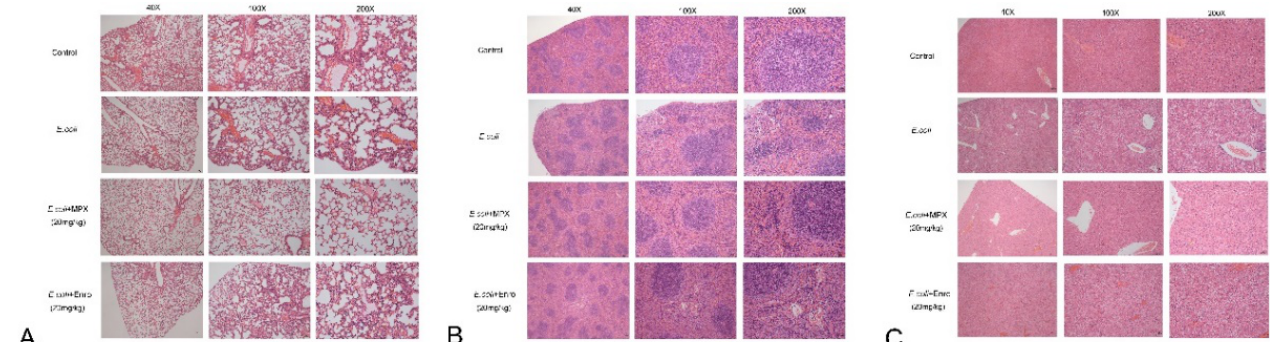
Fig. 5. H&E staining of the organs infected with E. coli in mice. A: H&E staining of lung infected with E. coli in mice; B: H&E staining of spleen infected with E. coli in mice; C: H&E staining of liver infected with E. coli in